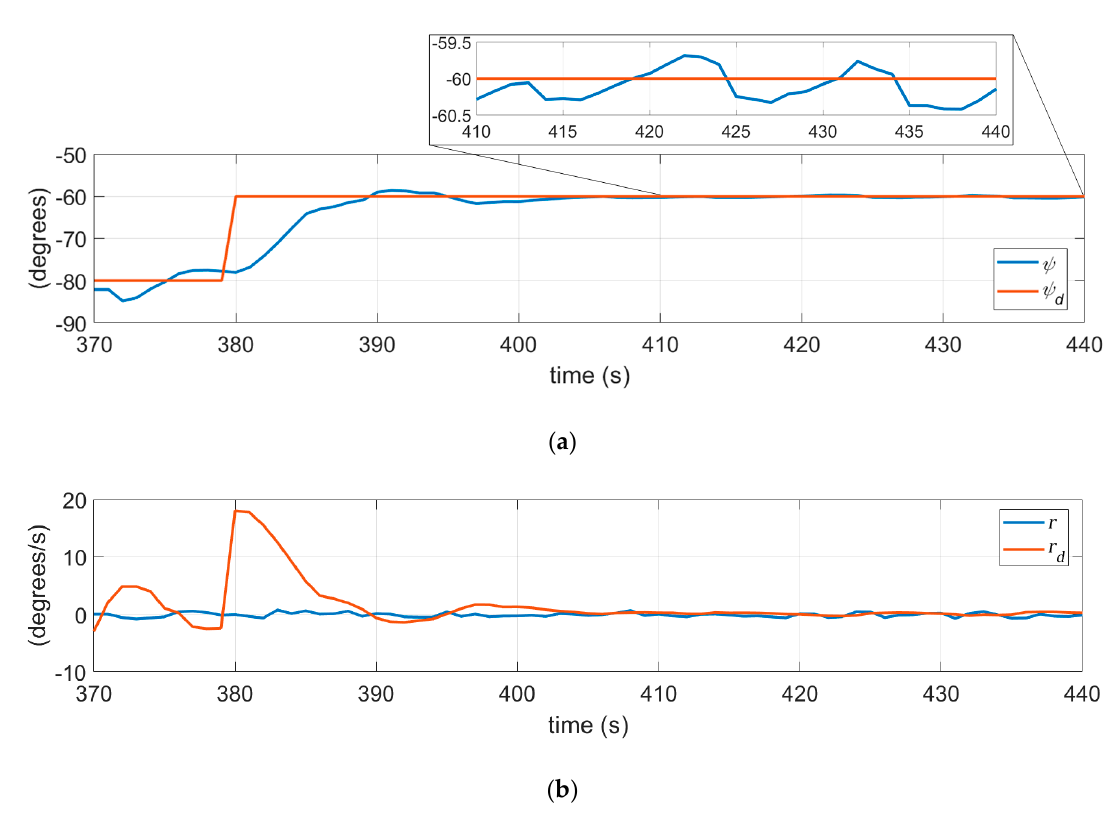
Figure 15. Experimental results of robust adaptive heading control in the water tank. ( a ) Heading control performance and ( b ) virtual control